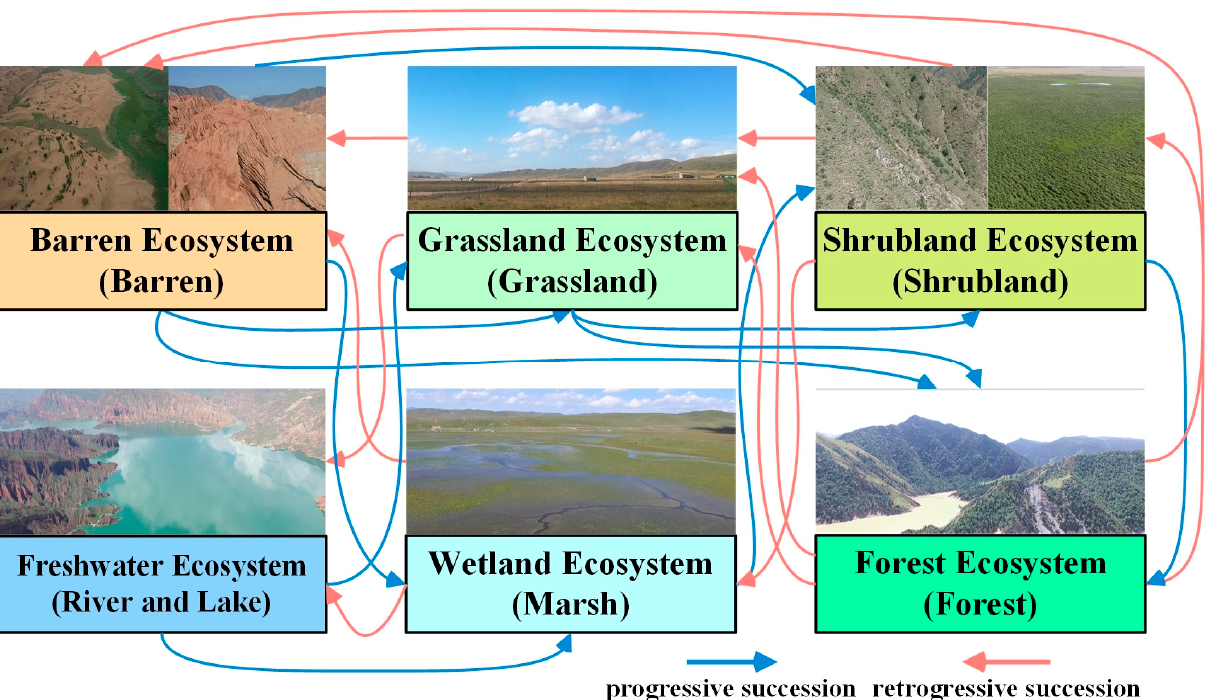
Figure 5. Schematic diagram of the ecological successions related to changes in ecosystem types. The LULC types under each ecosystem type are represented in parentheses.